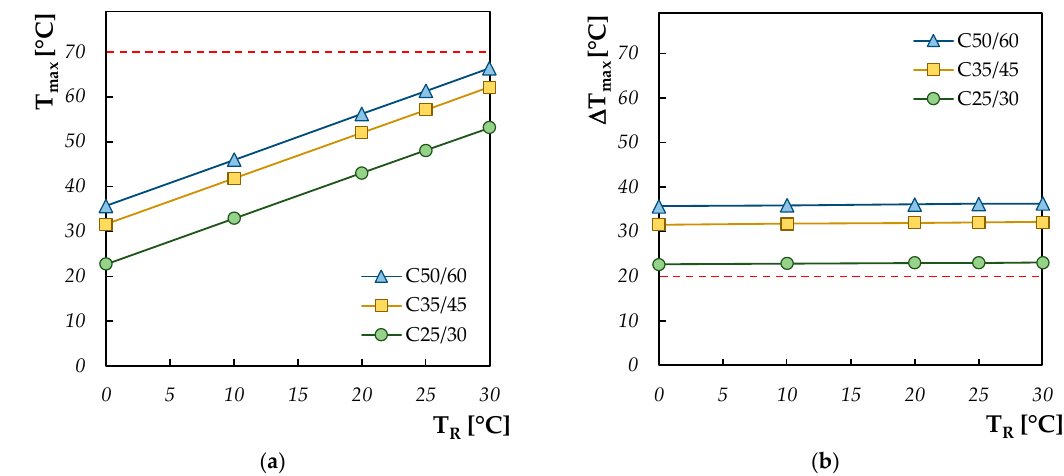
Figure 9. Maximum temperature ( a ) and maximum thermal gradient ( b ) by varying the ambient temperature.